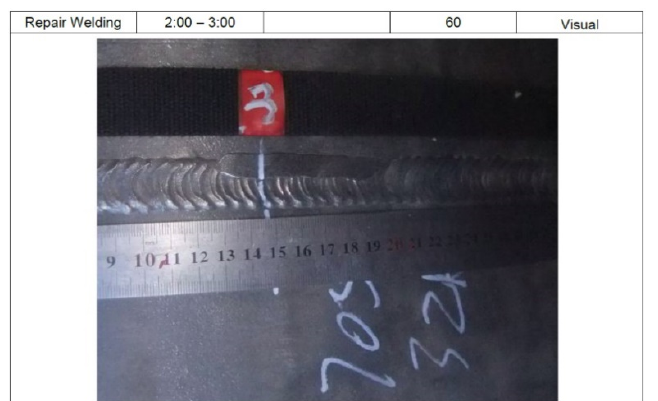
Figure 8. Picture of GW 7050.